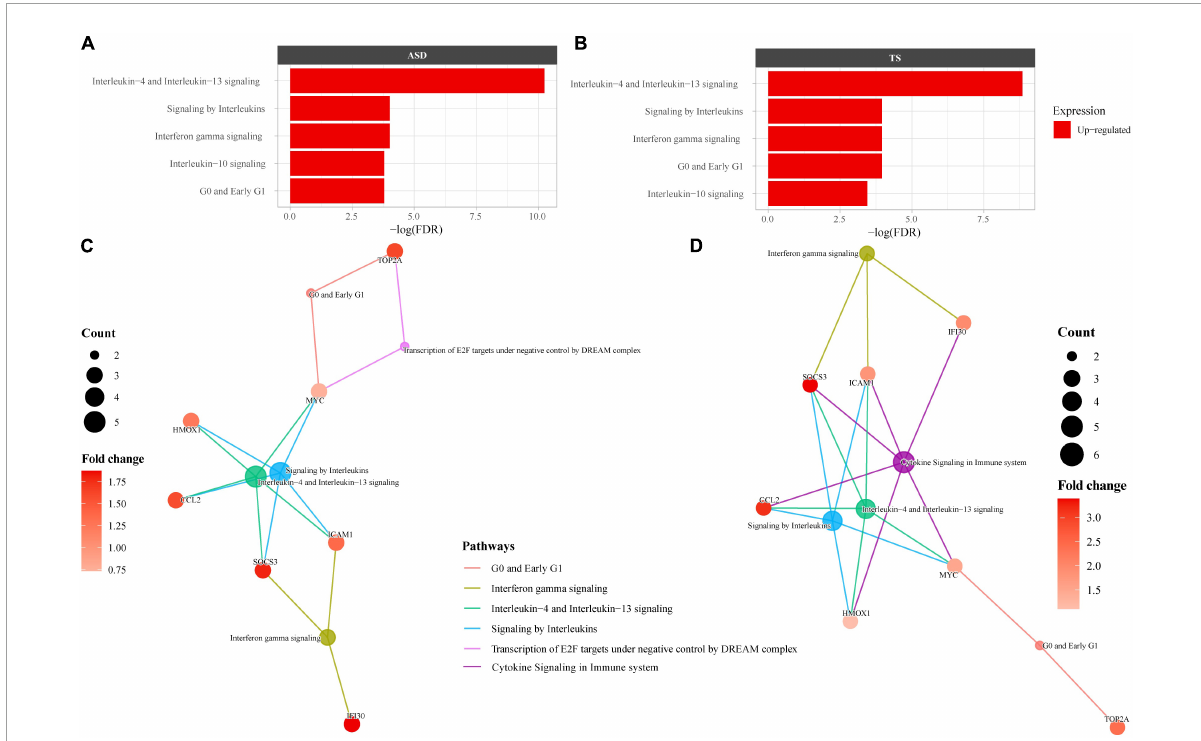
FIGURE4 Overrepresented Reactome pathways common to autism spectrum disorders (ASD) and Tourette syndrome (TS). Reactome enrichment analysis ( FDR < 0.05) of the common differentially expressed genes (DEGs) in the brain transcriptome of individuals with ASD compared with controls (A,C) and individuals with TS) compared with controls (B,D) . Panels (A,B) : ASD enrichment results (A) and TS enrichment results (B) presented as bar plots of the top 10 pathways (y-axis), with the statistical significance of the pathways presented by the x-axis. Panels (C,D) : Connectivity network (CNET) plots of the top 5 enriched pathways and the interactions of genes that make up the pathways, represented by each gene’s fold change. The enriched pathways in ASD (C) and TS (D) are represented by a